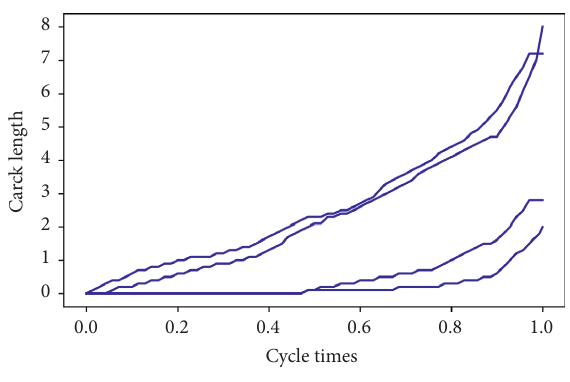
Figure 7: Normalized data of three holes with constant amplitude.